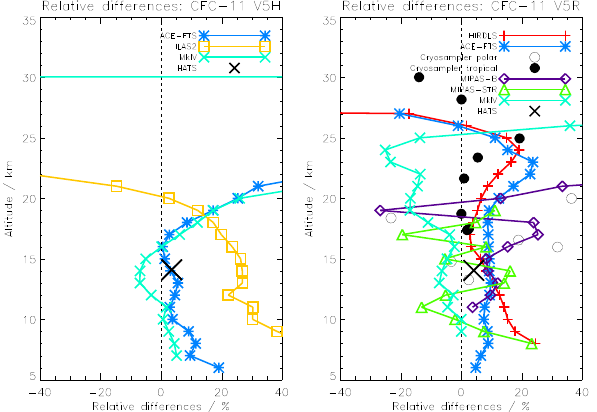
Figure 30. Relative differences between MIPAS CFC-11 for the FR (left) and RR (right) period and each comparison instrument, × 100%. calculated as MIPAS − Other MIPAS